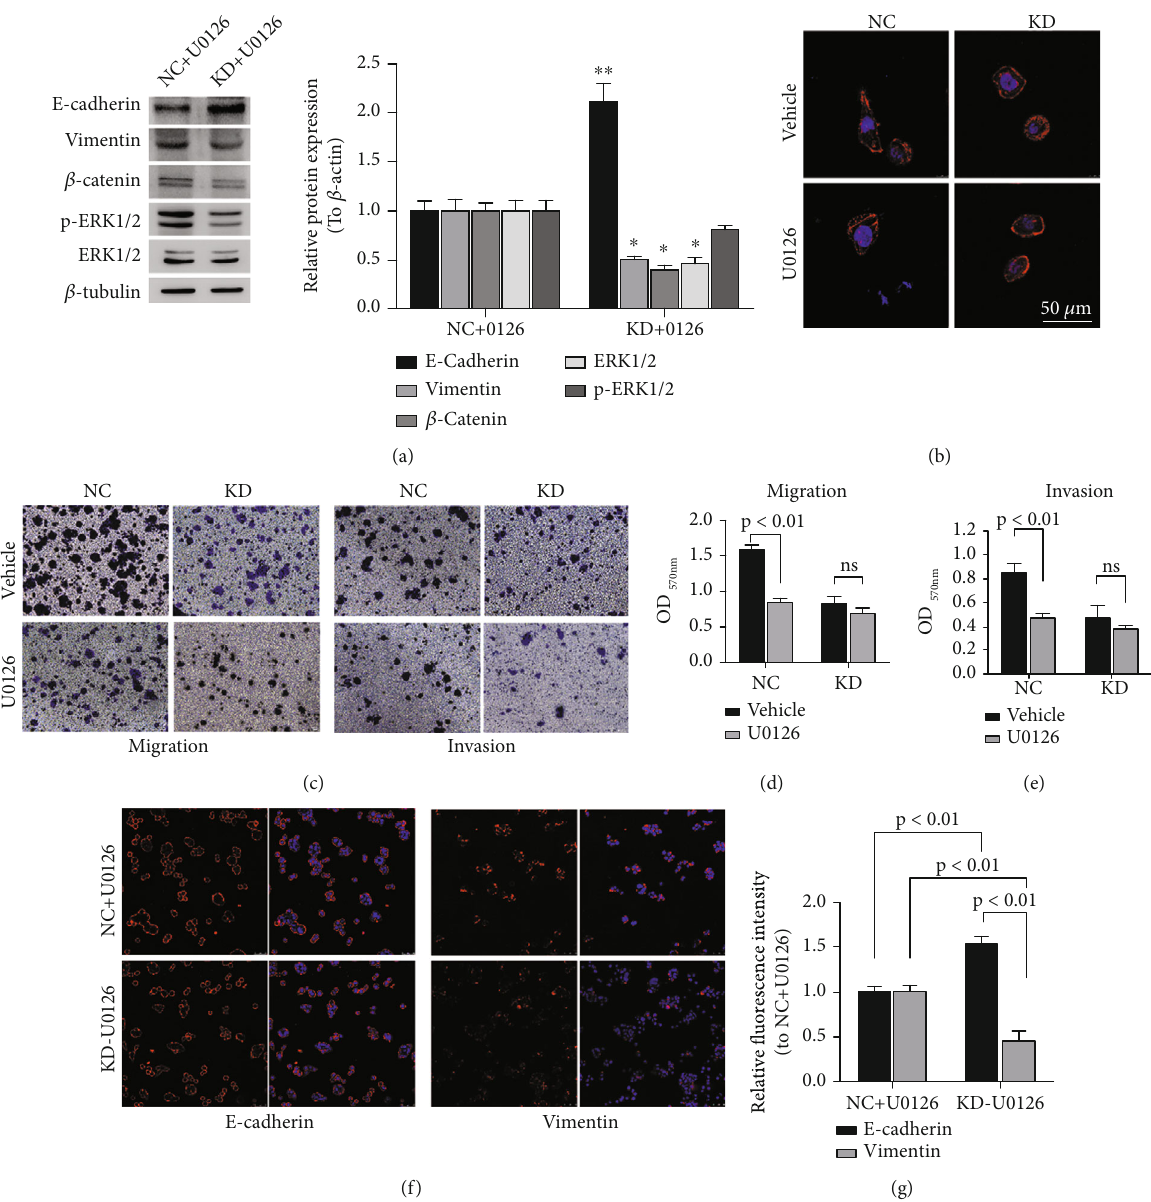
Figure 4: Decreased GRHL3 expression represses cell proliferation and invasion. (a) The protein expression of β -catenin, ERK1/2, p- ERK1/2, Vimentin, and E-cadherin was assayed by western blotting. (b) Cytoskeletal staining of F-actin. (c-e) Cell migration and invasion were detected by transwell in di ff erent treatment cells. (f, g) Vimentin and E-cadherin were assayed using immuno fl uorescence staining. Stably transfected knockdown expression of GRHL3 (GRHL3-KD) and negative control (NC) HT29 cells was treated with U0126 or solvent